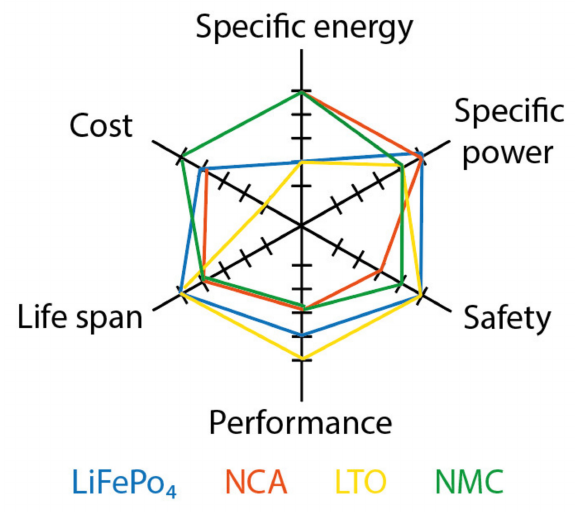
Figure 4. Spider chart for different technologies Lithium-ion batteries.